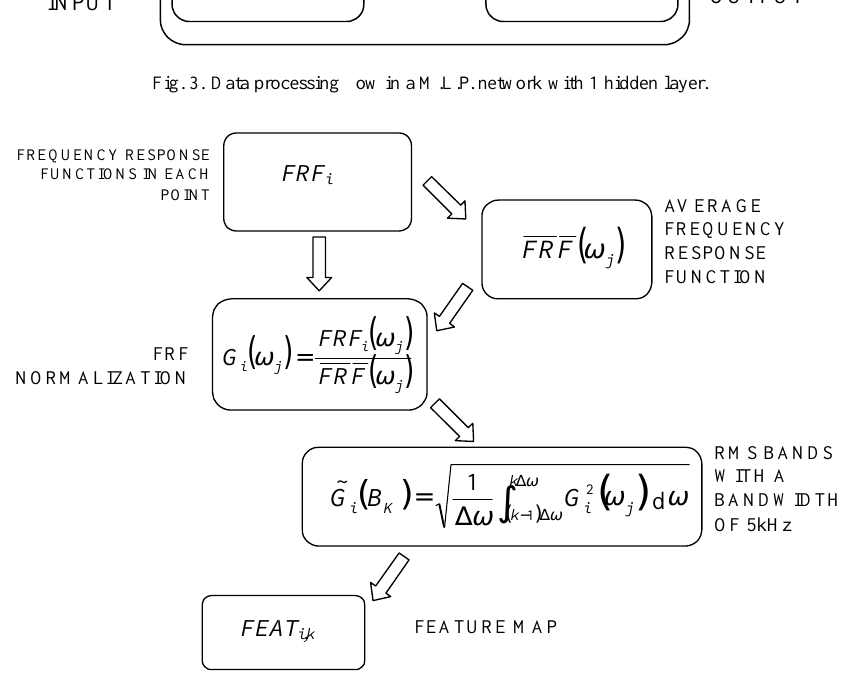
Fig. 4. Scheme of the procedure for features